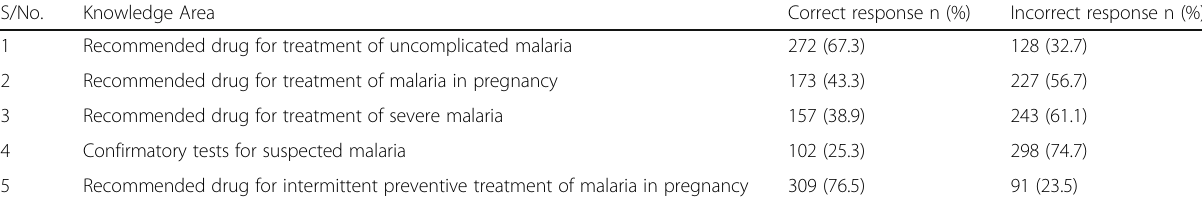
Table 2 Knowledge of malaria case management among healthcare providers, Lokoja ( N = 404)